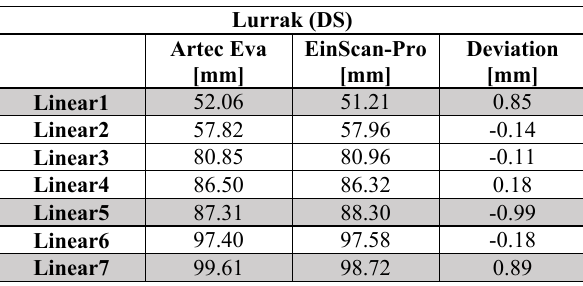
Table 1. DS analysis of the “Lurrak” model